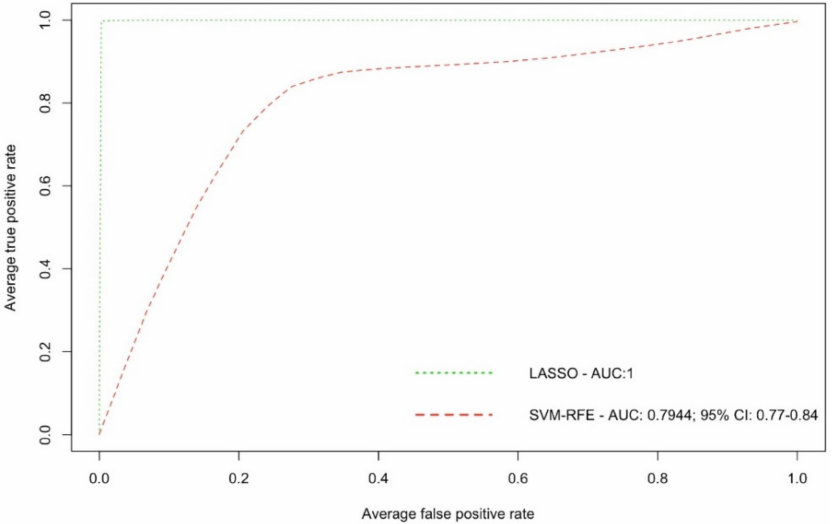
Figure 4. Receiver operating characteristics (ROC) curve with the area under the curve (AUC) showing the prediction performance of the 16 selected ions for the 15 test